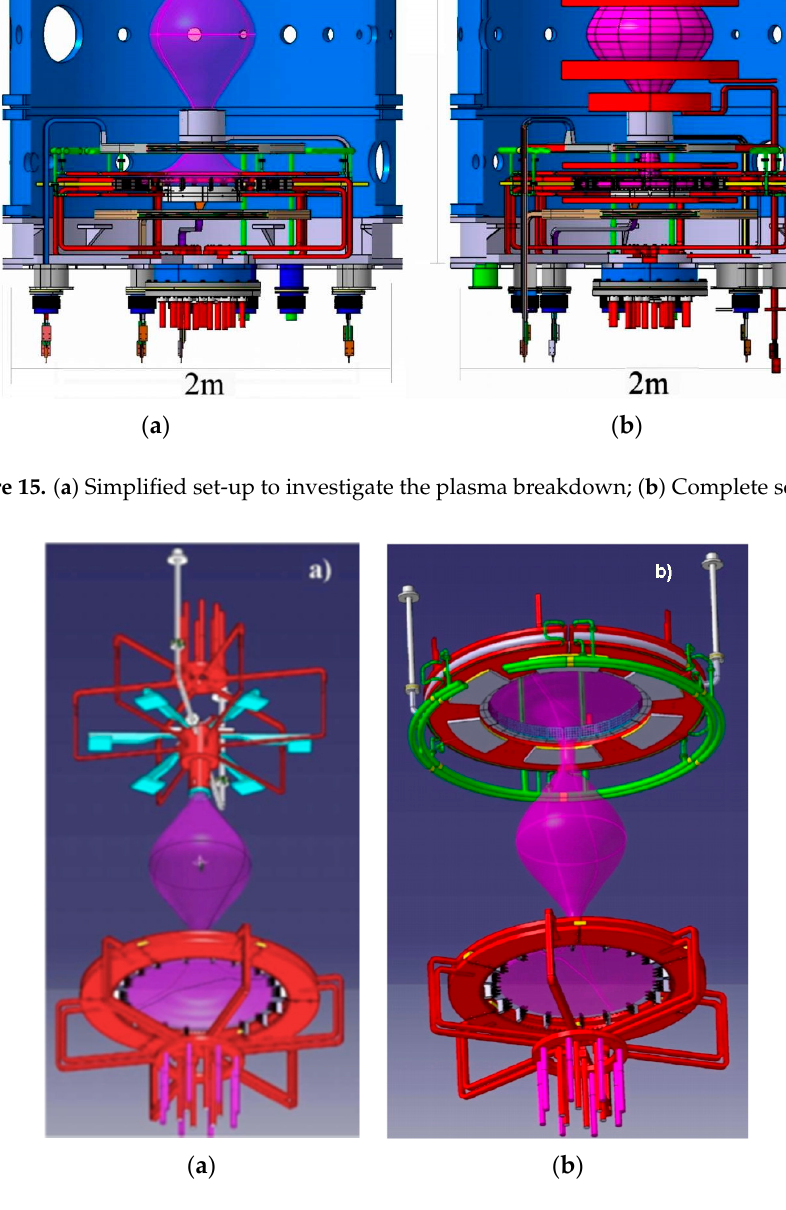
Figure 16. ( a ) Cylindrical anode; ( b ) Annular anode.